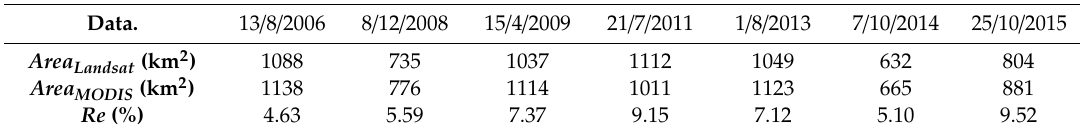
Table 2. Dongting Lake water area obtained from Moderate Resolution Imaging Spectroradiometer (MODIS) and Landsat